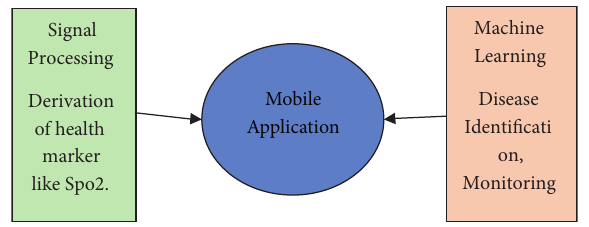
Figure 4: Mobile app identifying several diseases using